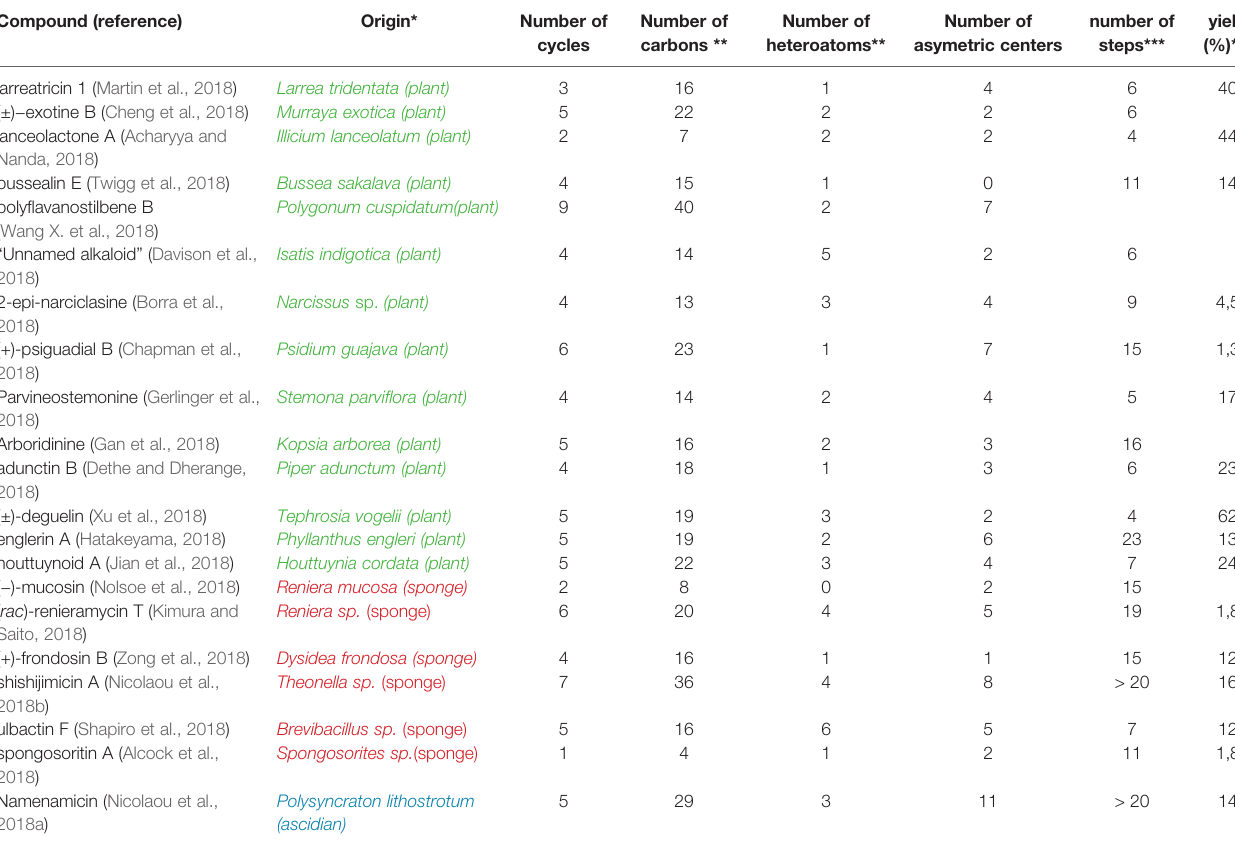
*The origin of the compounds is color-coded: light red: insect; black: bacteria; light blue: fungus; violet: mushroom; green: plants and trees; dark red, sponge; dark blue: ascidian. ** The numbers of carbon atoms and of heteroatoms were those included in the cycles. ***Yellow cells: approx. calculations by the present authors. Gray cells: This information is too deeply embedded in the